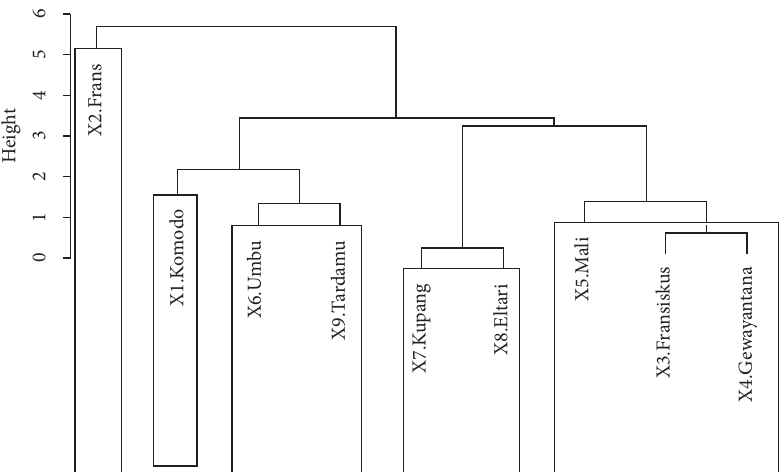
Figure 2: Dendrogram for grouping stations using Ward’s method with five clusters. The clustering results follow the existing geographical conditions. This can be seen in the distribution of the clustering results in Figure 3.